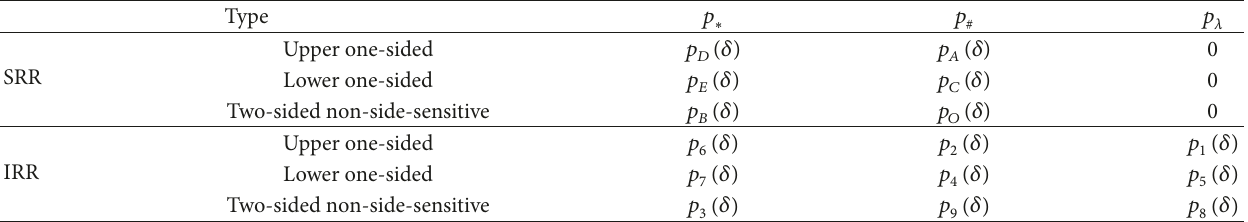
Table 8: The elements of the TPM of the upper or lower one-sided and the two-sided non-side-sensitive SRR and IRR w-of-w monitoring schemes.